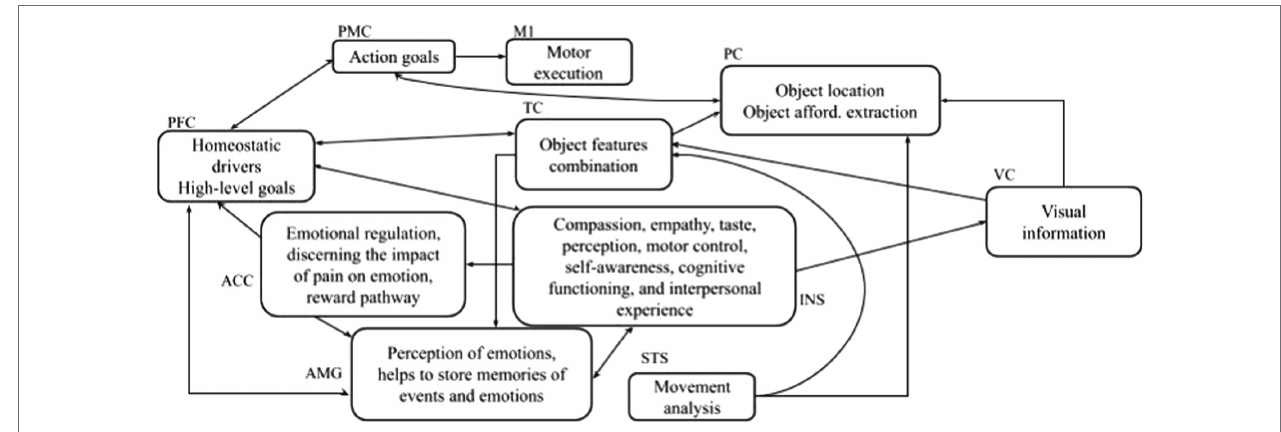
FIGURE 8 | The brain areas and their functions are involved in affordance and emotions. INS : insula; VC : visual cortex; M1: motor area; ACC: anterior cingulate cortex; PFC: prefrontal cortex representing dlPFC, vlPFC, dmPFC; PMC : premotor cortex; AMG : amygdala; TC : temporal cortex; PC: parietal cortex; and STC: superior temporal